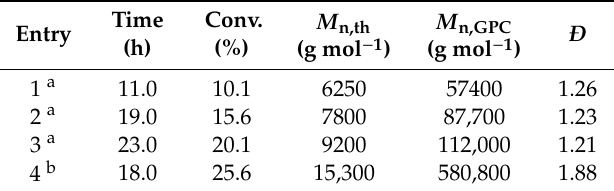
Table 2. Synthesis of the water-soluble block copolymer.